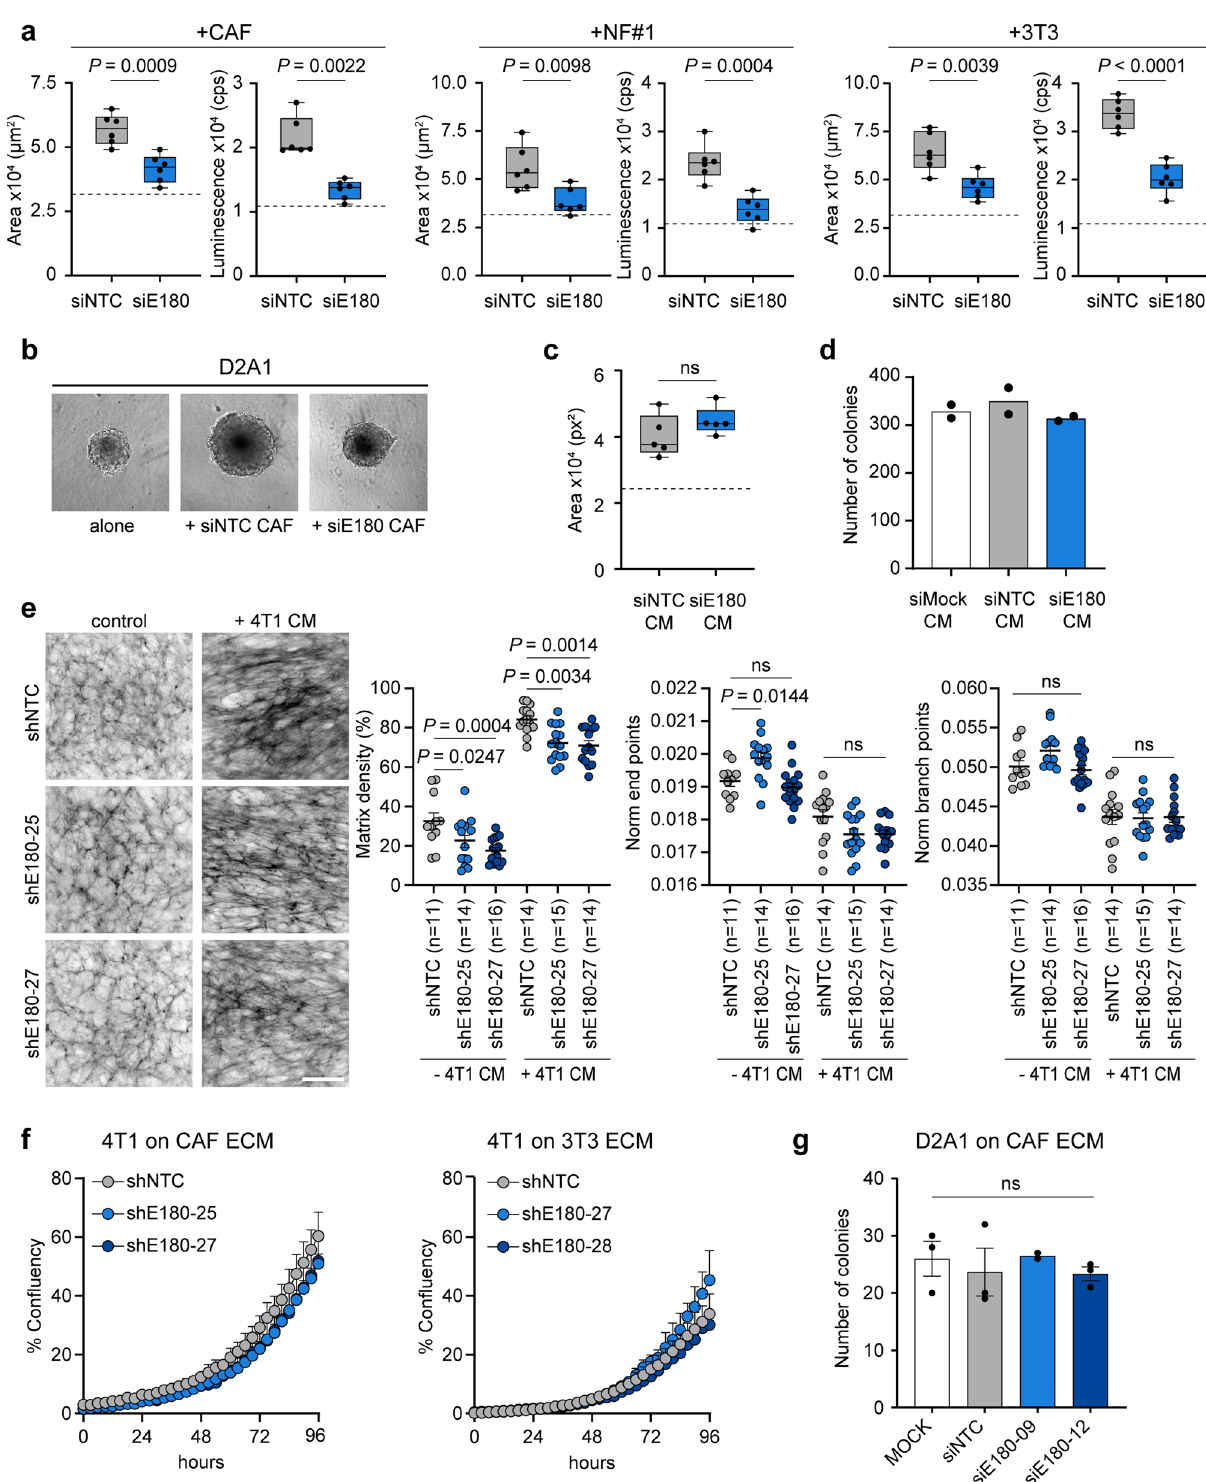
exome sequencing and transcriptional pro fi ling. Exome sequen- cing reveals that, when compared to a reference BALB/c genome, the D2A1 and D2A1-m12 cell lines display a similar copy number aberration pro fi le (Supplementary Fig. 8c) as expected given that the D2A1-m12 subline is derived from the D2A1 parental cells. Comparison of their mutation pro fi les reveals a similar mutation burden in the D2A1 and D2A1-m12 cell lines (Supplementary